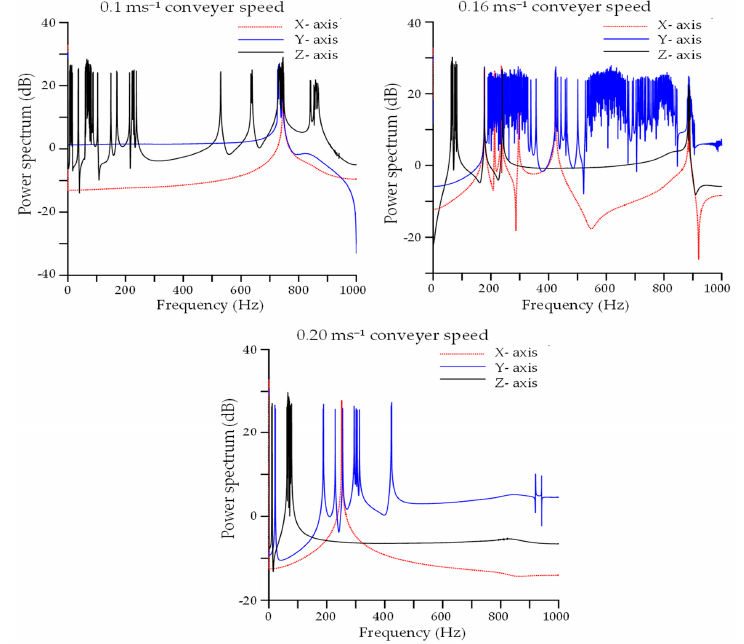
Figure 8. Power spectrum density (PSD) analysis of the measured vibration on the first conveyor belt for 0.10, 0.16, and 0.20 ms − 1 conveyor speeds and loaded condition.